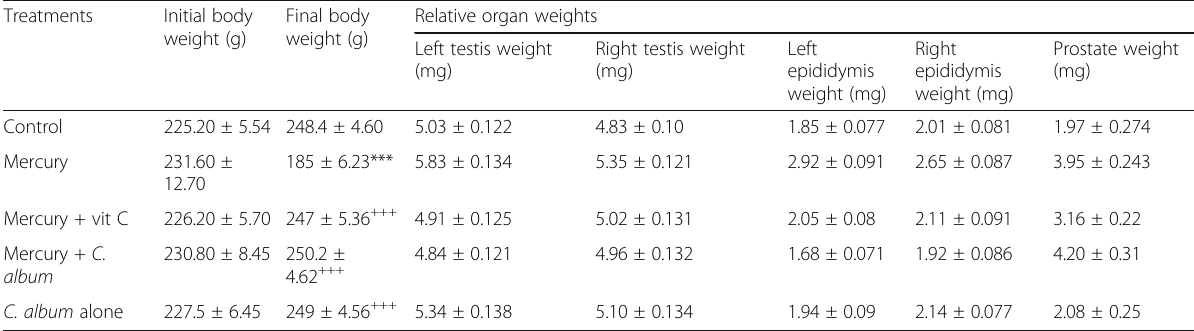
Table 1 Effect of different treatments on body and reproductive organ weights Treatments